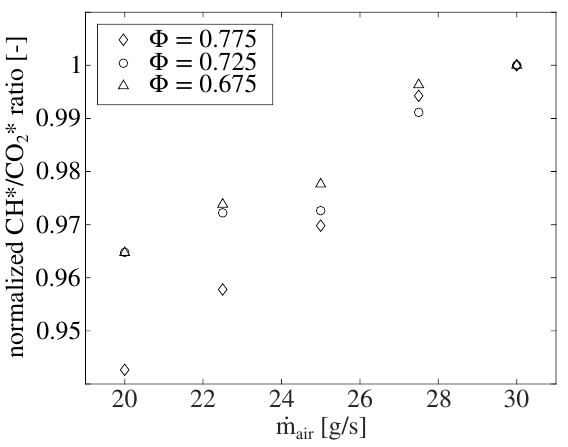
Figure 8. The dependence of the CH*/CO 2 * chemiluminescence ratio on the air mass flow rate ˙m air for the combustion of natural gas under atmospheric conditions for different equivalence ratios. All values are normalized to the respective ratio at ˙m air =30g/s.